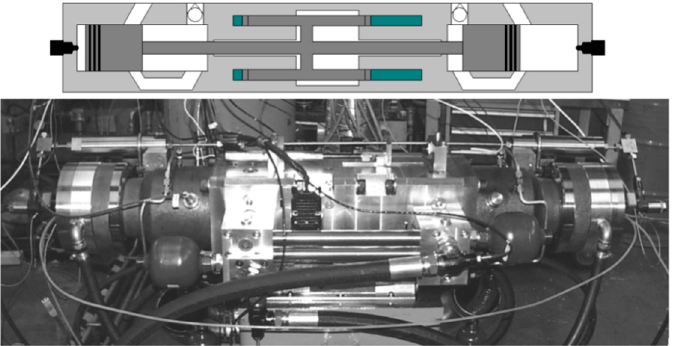
Figure 16. The dual-piston HFPE principle prototype of Tampere Polytechnic University [46].